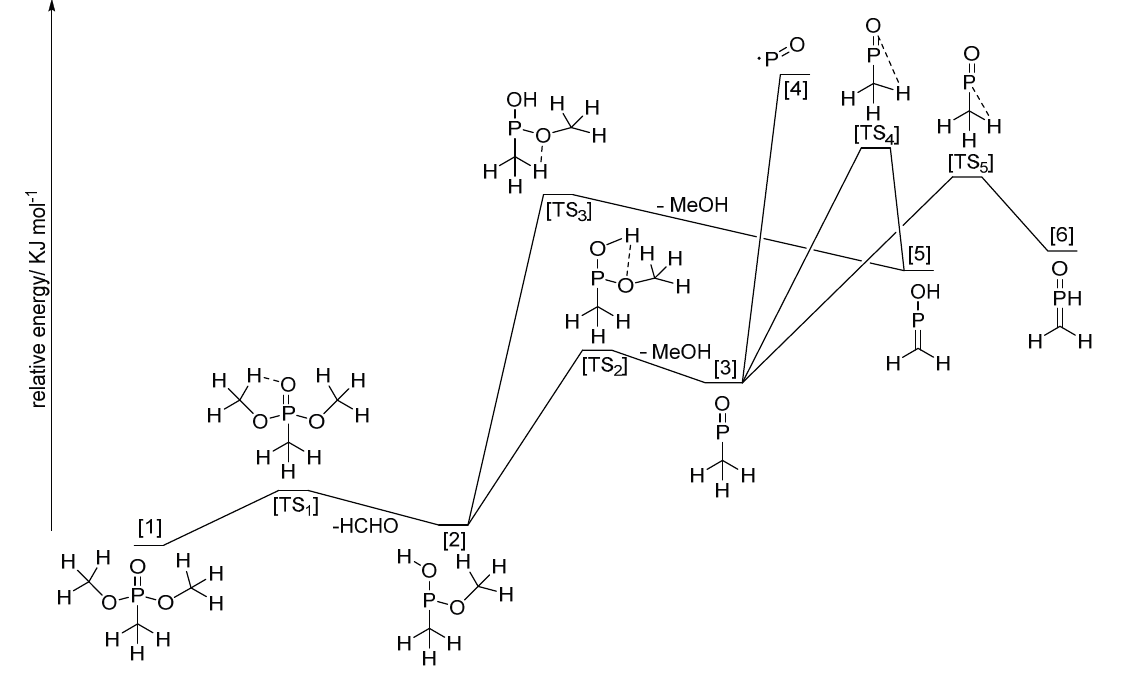
Figure 4. CBS-QB3 (Quantum chemistry composite method) energy diagram for thermal decomposition of dimethyl methyl phosphonate (DMMP) (pathway